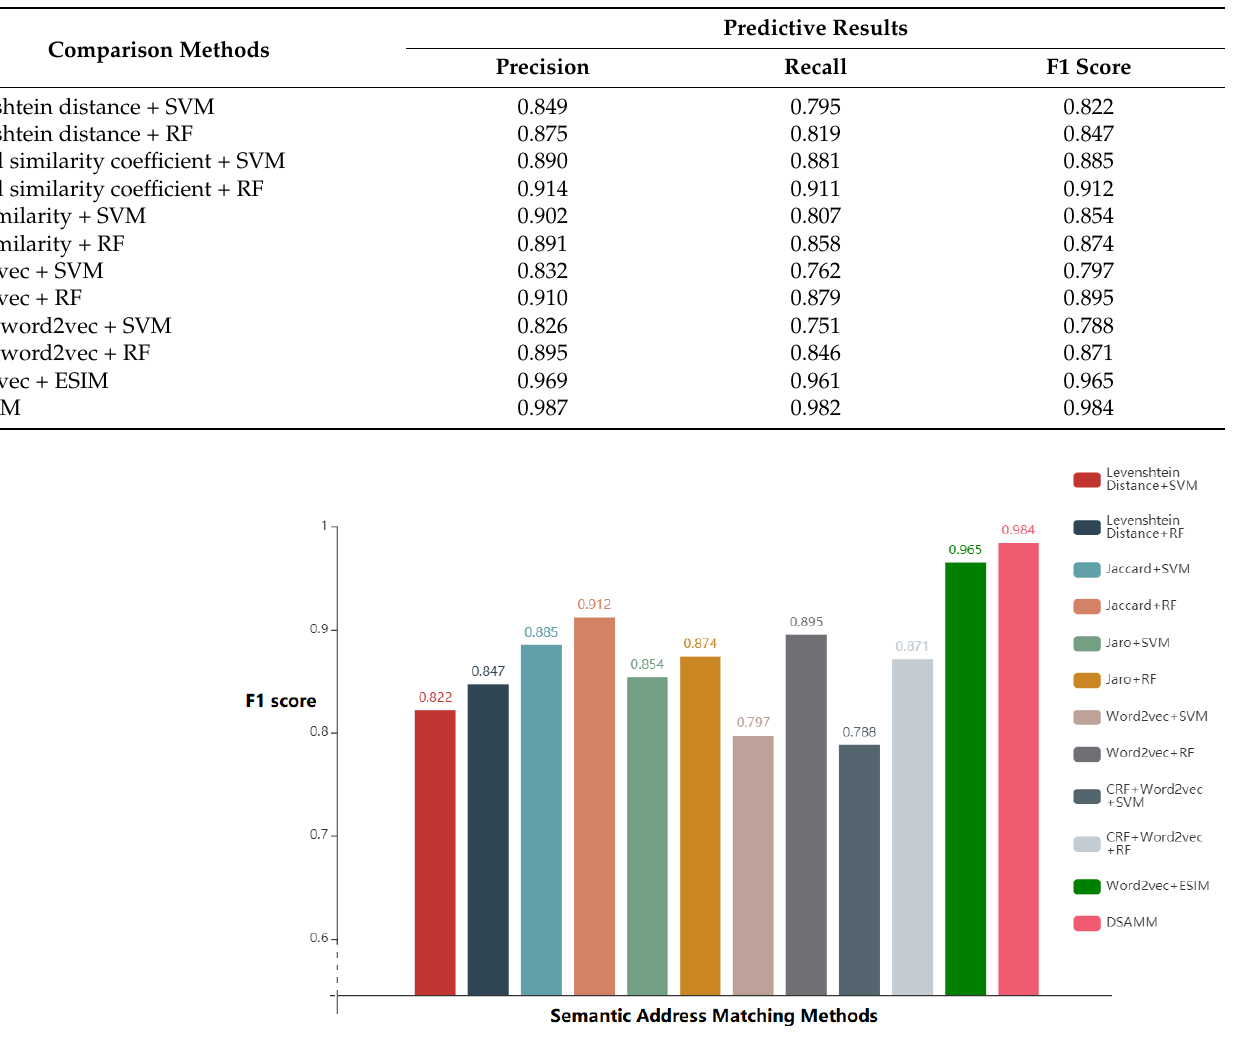
Figure 7. Comparative evaluations of different address matching methods in F1 score.